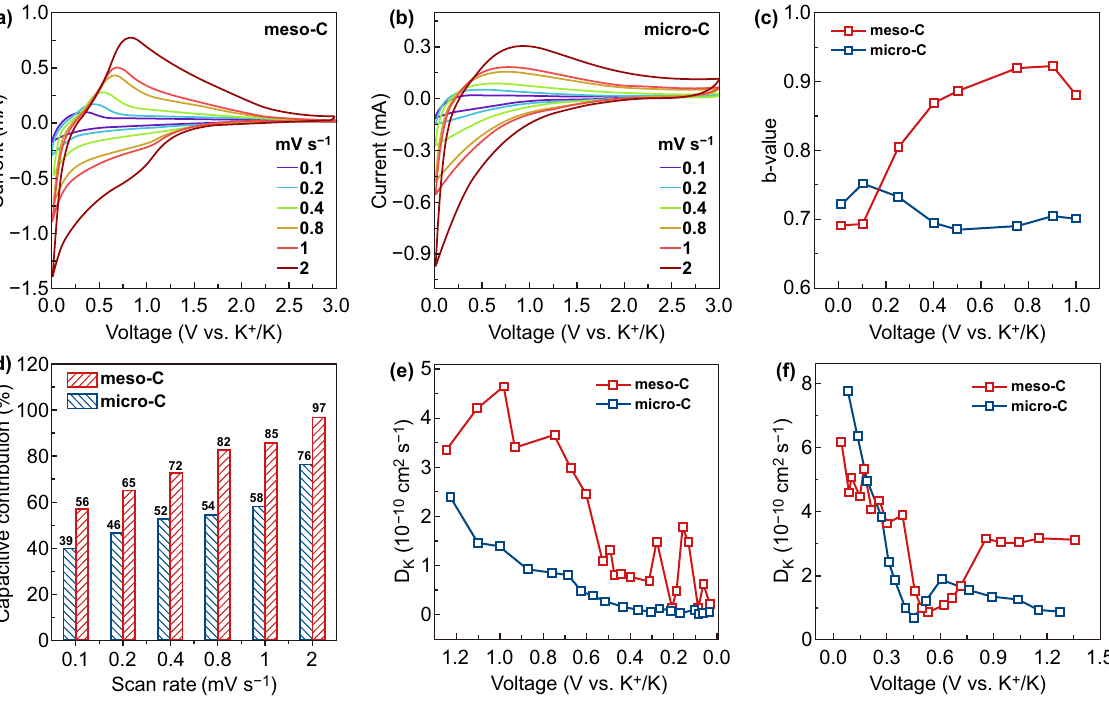
Fig. 5 Kinetics analysis of K-storage. CV curves at various scan rates of a meso-C and b micro-C. c Calculated b values for meso-C and micro- C for cathodic sweep. d Contribution of the surface-controlled process in meso-C and micro-C at different scan rates. K-ion diffusion coefficient as a function of the state of e the discharging process and f the charging